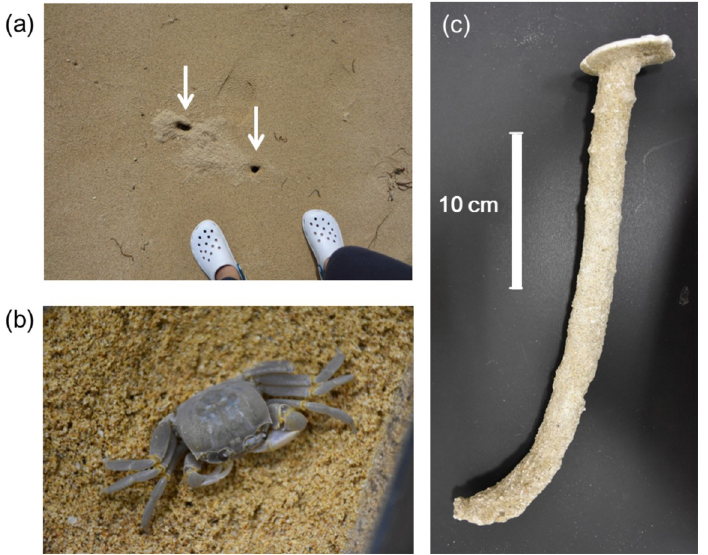
Fig 1. Ghost crabs and their burrows. Panels: (a) Burrow entrances of ghost crabs on a sandy beach on Ishigaki Island, Okinawa Prefecture, Japan (arrows point to the burrow entrances), (b) the horn-eyed ghost crab Ocypode ceratophthalma , and (c) a plaster mold (cast) of a ghost crab burrow obtained from in Ishigaki Island, where Ocypode ceratophthalma dominants the ghost crab